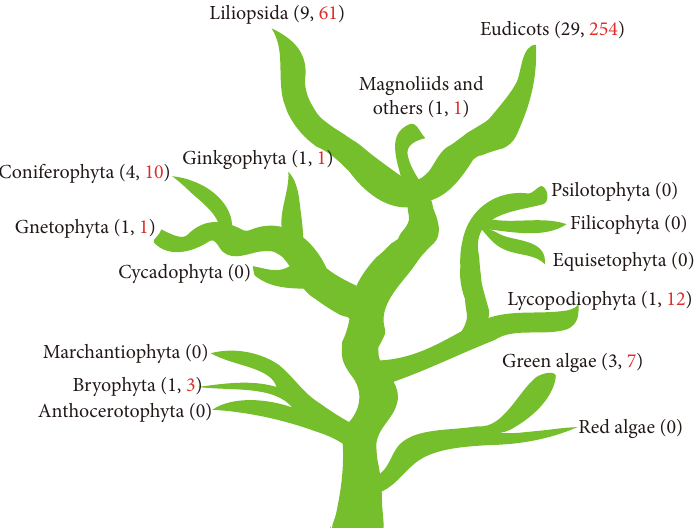
Figure 1: Summary of investigated plant species and their phylogenetic relationship. There were 350 WOX sequences of 50 species in 21 families from green algae to angiosperms. The numbers in black mean the amount of species and the numbers in red mean the amount protein sequences of WOX family. The species include Arabidopsis lyrata , Arabidopsis thaliana , Arachis hypogaea , Artemisia annua , Brassica napus , Brassica rapa , Carica papaya , Citrus sinensis , Cucumis sativus , Glycine max , Gossypium hirsutum , Helianthus annuus , Lotus japonicus , Malus x domestica , Manihot esculenta , Medicago truncatula , Mimulus guttatus , Nicotiana tabacun , Petunia x hybrida , Phaseolus coccineus